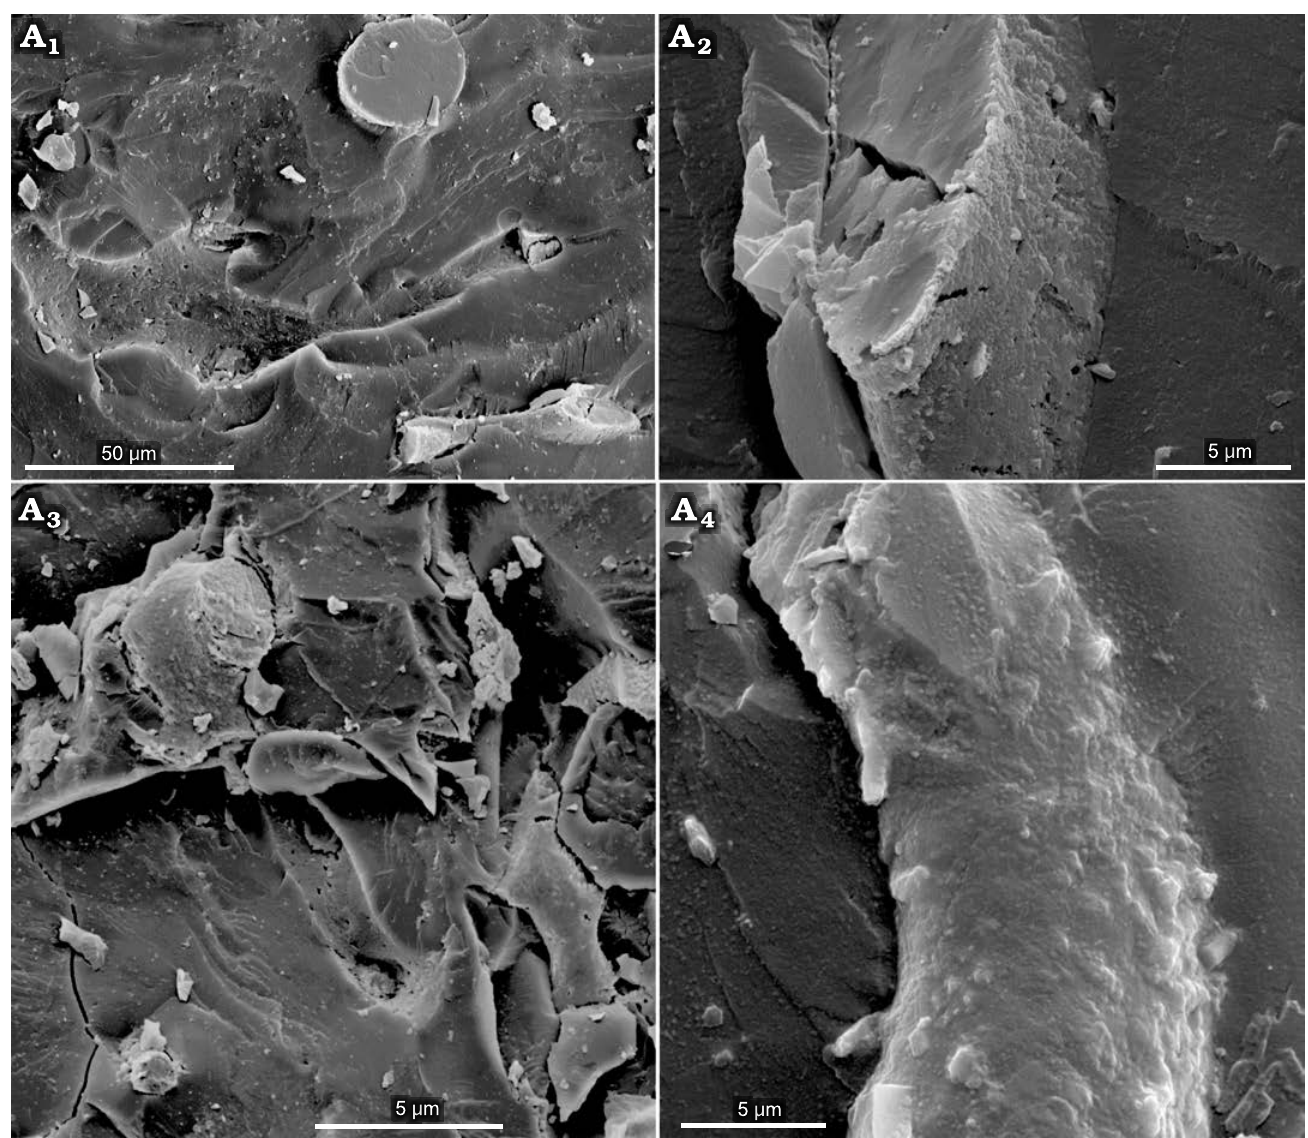
Fig. 10. The ultrastructure of the hypothesized “beak” of the coleoid cephalopod Phragmoteuthis bisinuata (Bronn, 1859) (GBW 2006/011/0009); lower Carnian, Upper Triassic, Cave del Predil, NE Italy. A 1 , A 2 , a fracture of the structureless matrix containing bone-like nanostructures or their imprints; A 3 , a complex bone-like structure within the matrix; A 4 , a warty outer surface of the bone-like structure; the longest warts leave a “micro-porosity” of the imprints left by bone-like